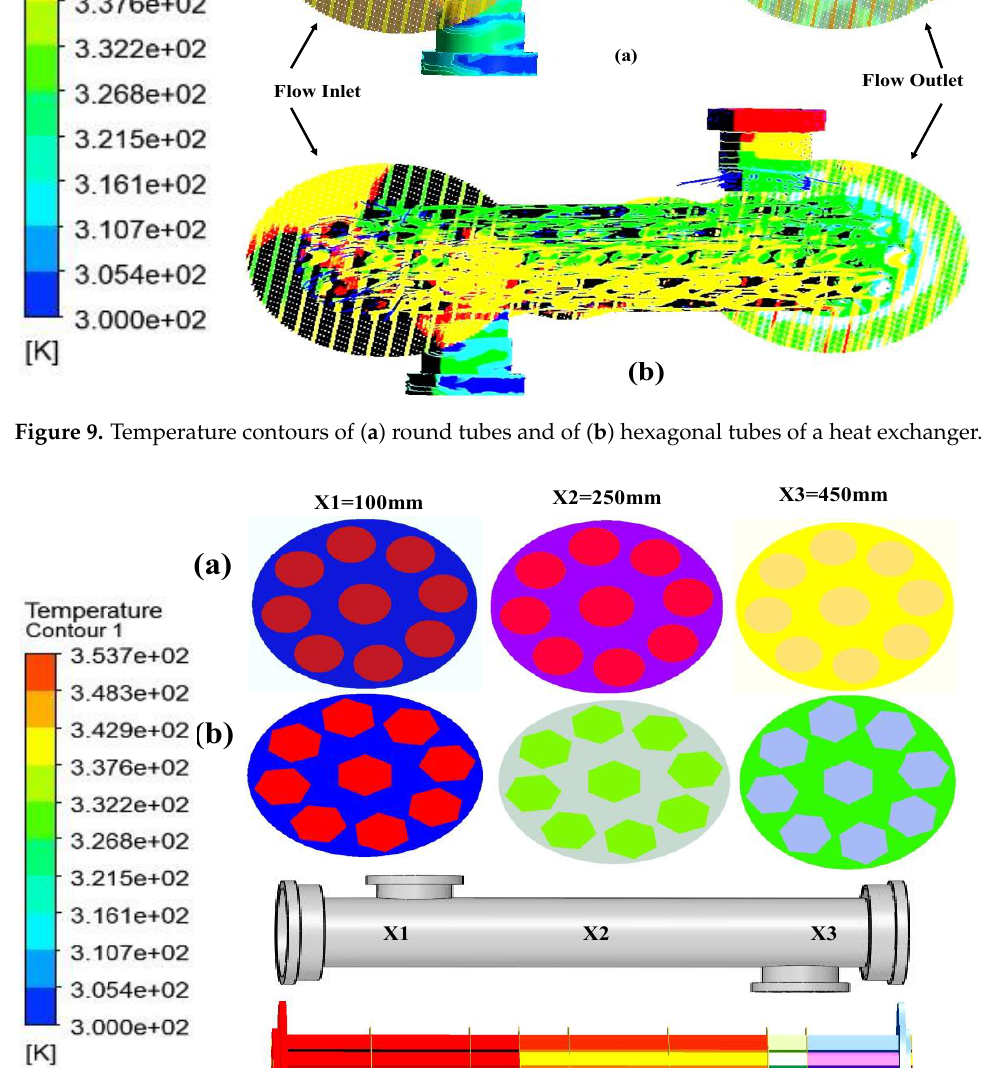
Figure 10. Temperature contours at cross-sections of ( a ) round tubes and ( b ) hexagonal tubes of a heat exchanger at 100 mm, 250 mm, and 450 mm.